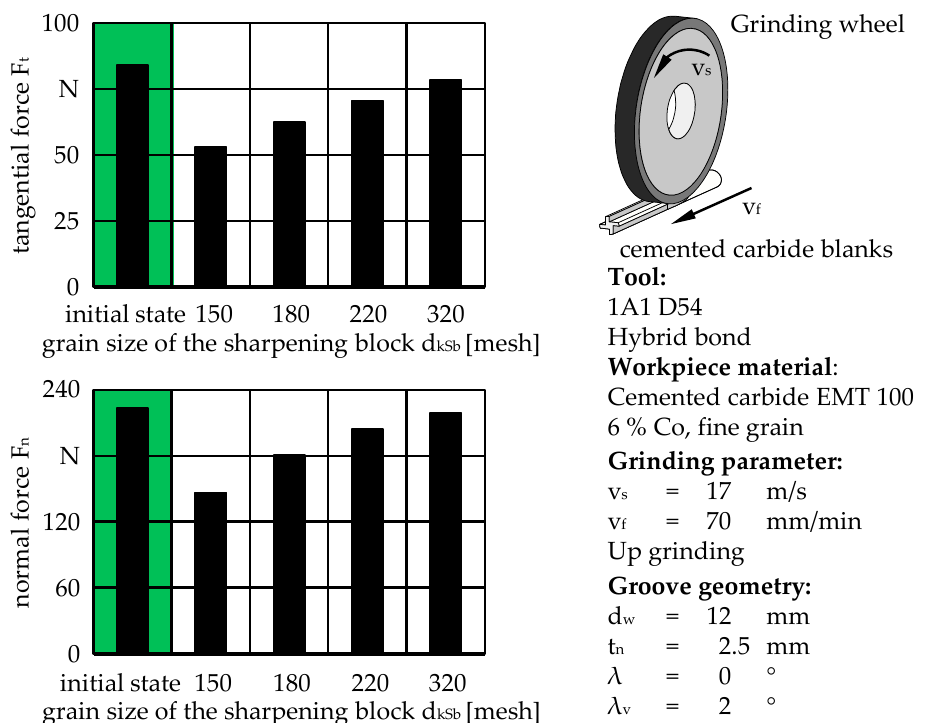
Figure 8. Influence of the grain size of the sharpening block d kSb on the grinding forces.